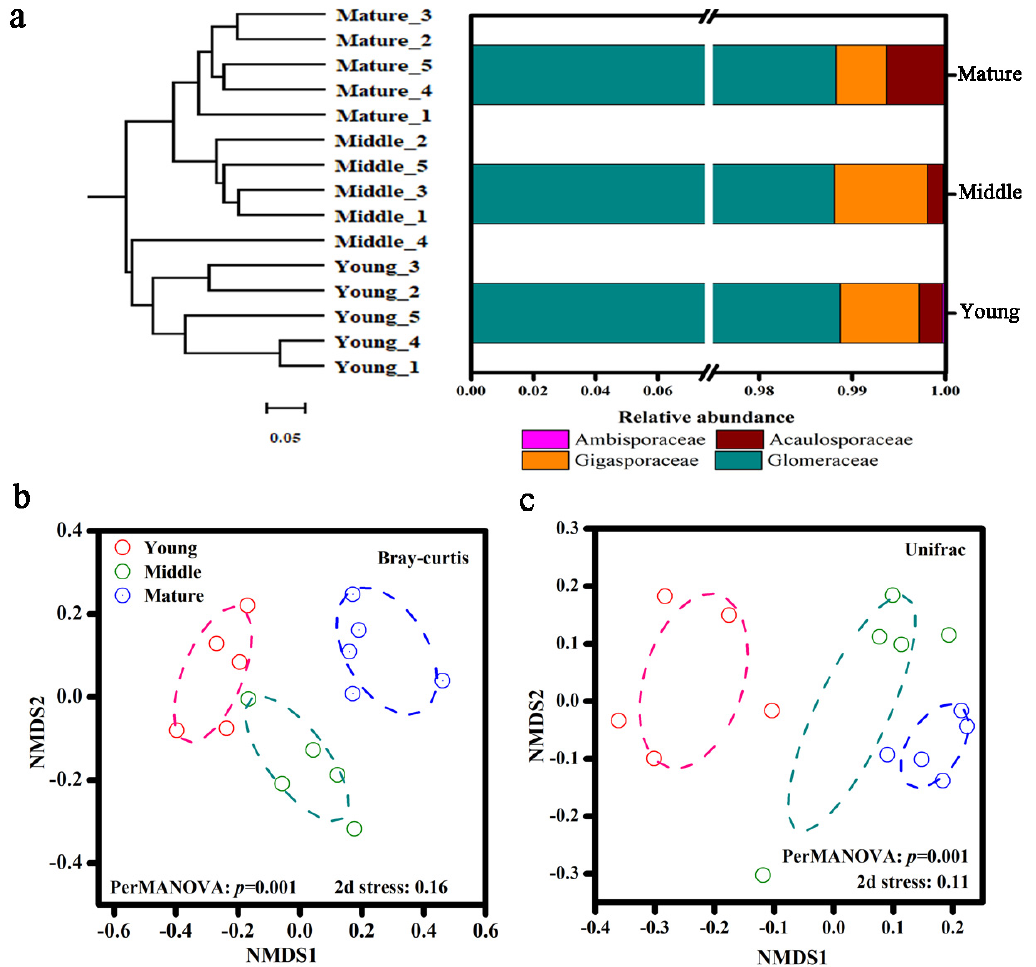
Figure 4. Relative abundances at family level ( a ), taxonomic composition ( b ) and phylogenetic composition ( c ) of soil AM fungal communities during the development of C. lanceolata plantations.